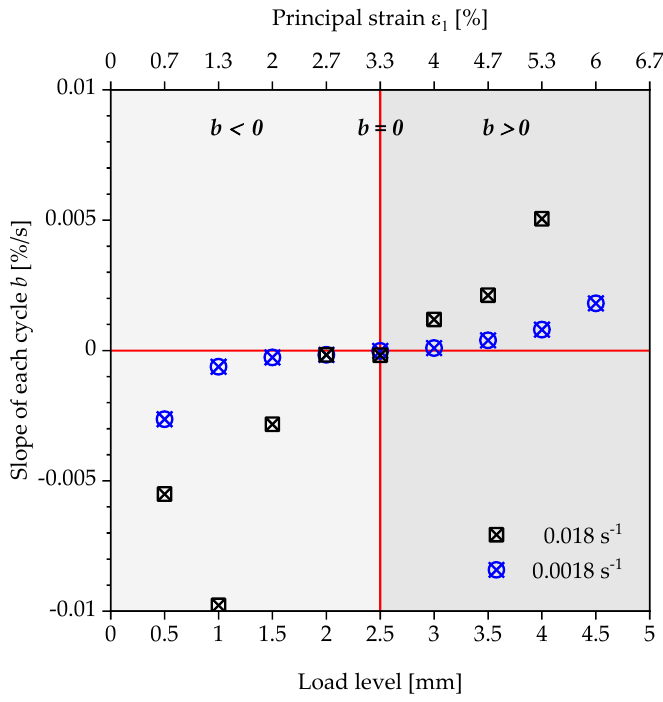
Figure 12. Plot of the slopes of the residual energy ratio curve within the specific load levels’ respective strain levels for the polyurethane system puroclear ® under tensile load.